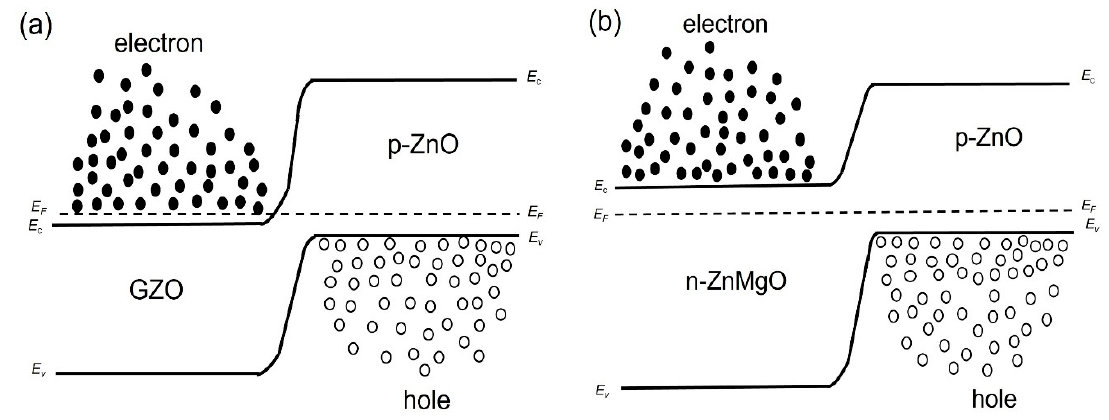
Figure 4. Band diagrams at thermal equilibrium state conditions (band bending is not taken into account) ( a ) p-ZnO/GZO homojunction; ( b ) p-ZnO/n-ZnMgO heterojunction.